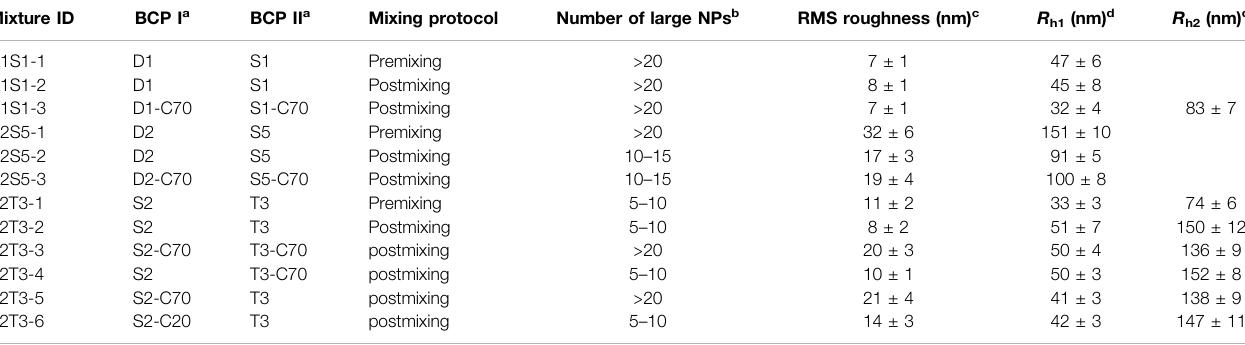
TABLE 3 | Mixing strategy at a 1:1 mass ratio of BCPs and properties of the binary mixtures of PS – PVP BCP NPs. Mixture